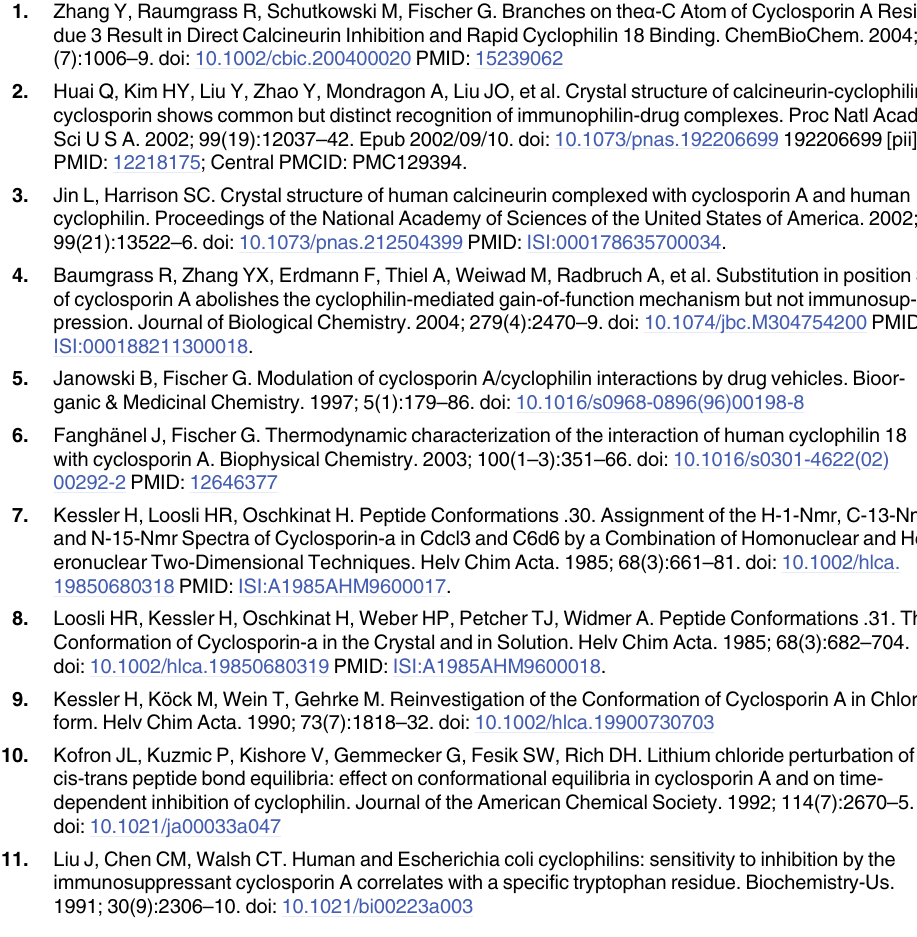
S1 Table. Fluorescence intensity of Cyp18 upon the binding of CsA. S2 Table. The parameters used to do the fitting by Berkeley modenna (Up numbers) and the parameters observed after the fitting (Down number). The range of k fitting was board (highlight), whereas the fitting showed closed value to the predicted, this indi- cated the conformational selection model was the most dominant process of CsA binding to Cyp18 in aqueous